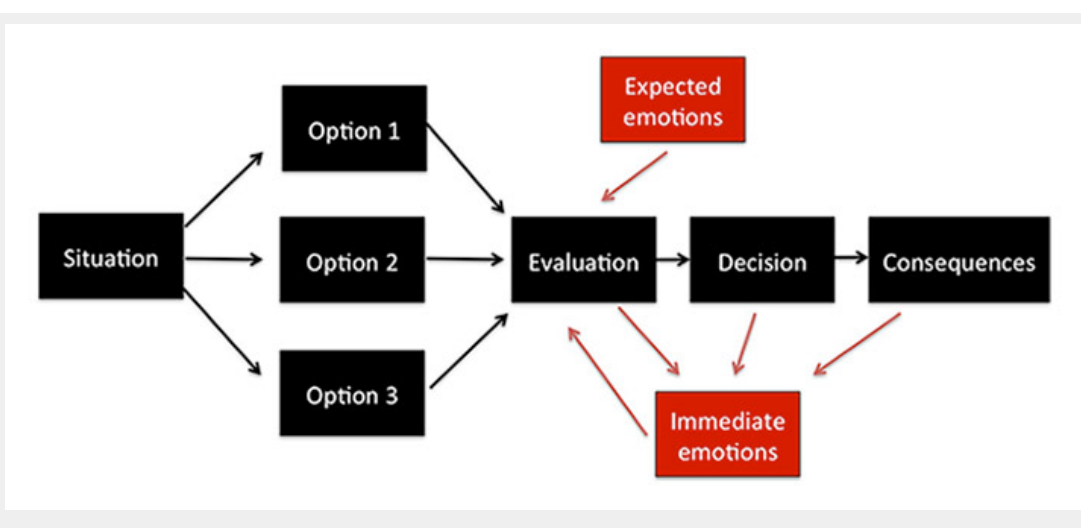
Figure 4 Schematic illustration of the stages of decision-making and the impact of emotion. When faced with a choice, we evaluate the options, weigh the possible consequences and their probabilities, and choose an option, and are confronted with the consequences. Expected emotions may influence our evaluation of behavioural options (for example, I may expect to be very happy once I buy the new luxury car, or I may have a gut feeling that it’s better to avoid a certain car dealer) and thus inform the choice at hand. Once a decision has been taken, the immediate consequences will also elicit emotions such as joy, relief, regret or disappointment, which may inform future choices or lead us to modify our current